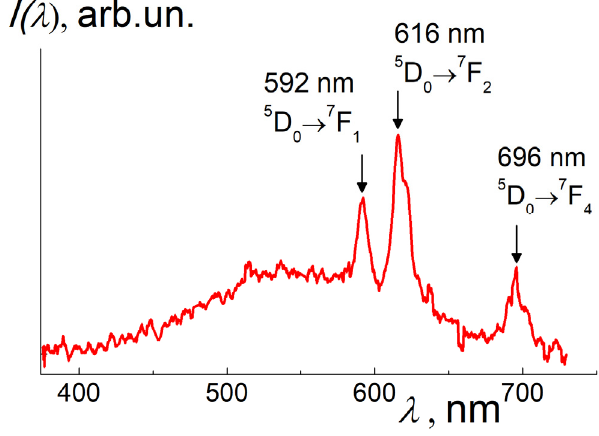
Figure 8. XEOL spectrum (excitation energy 8 keV) for the powder sample SEu1. The Eu-peaks at characteristic wavelengths and corresponding electron transitions are marked. The luminescence from the phases of graphite, diamonds, and aragonite is visible in a wide band (400–700 nm).